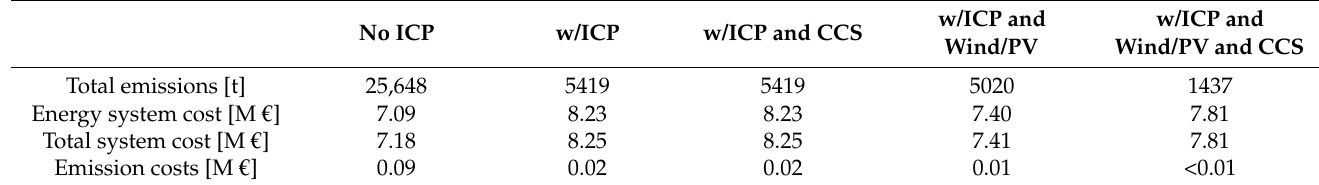
Table 8. Cost and emission overview for the Japanese